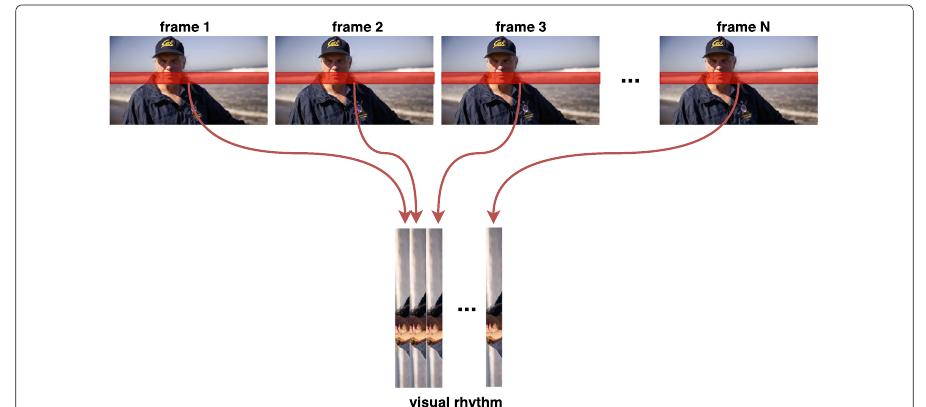
Fig. 5 Example of horizontal visual rhythm construction from a small set of columns of each frame